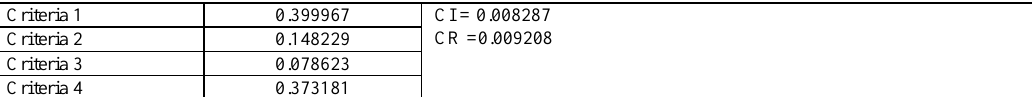
Table 8. Weights of criteria calculated by fuzzy-AHP